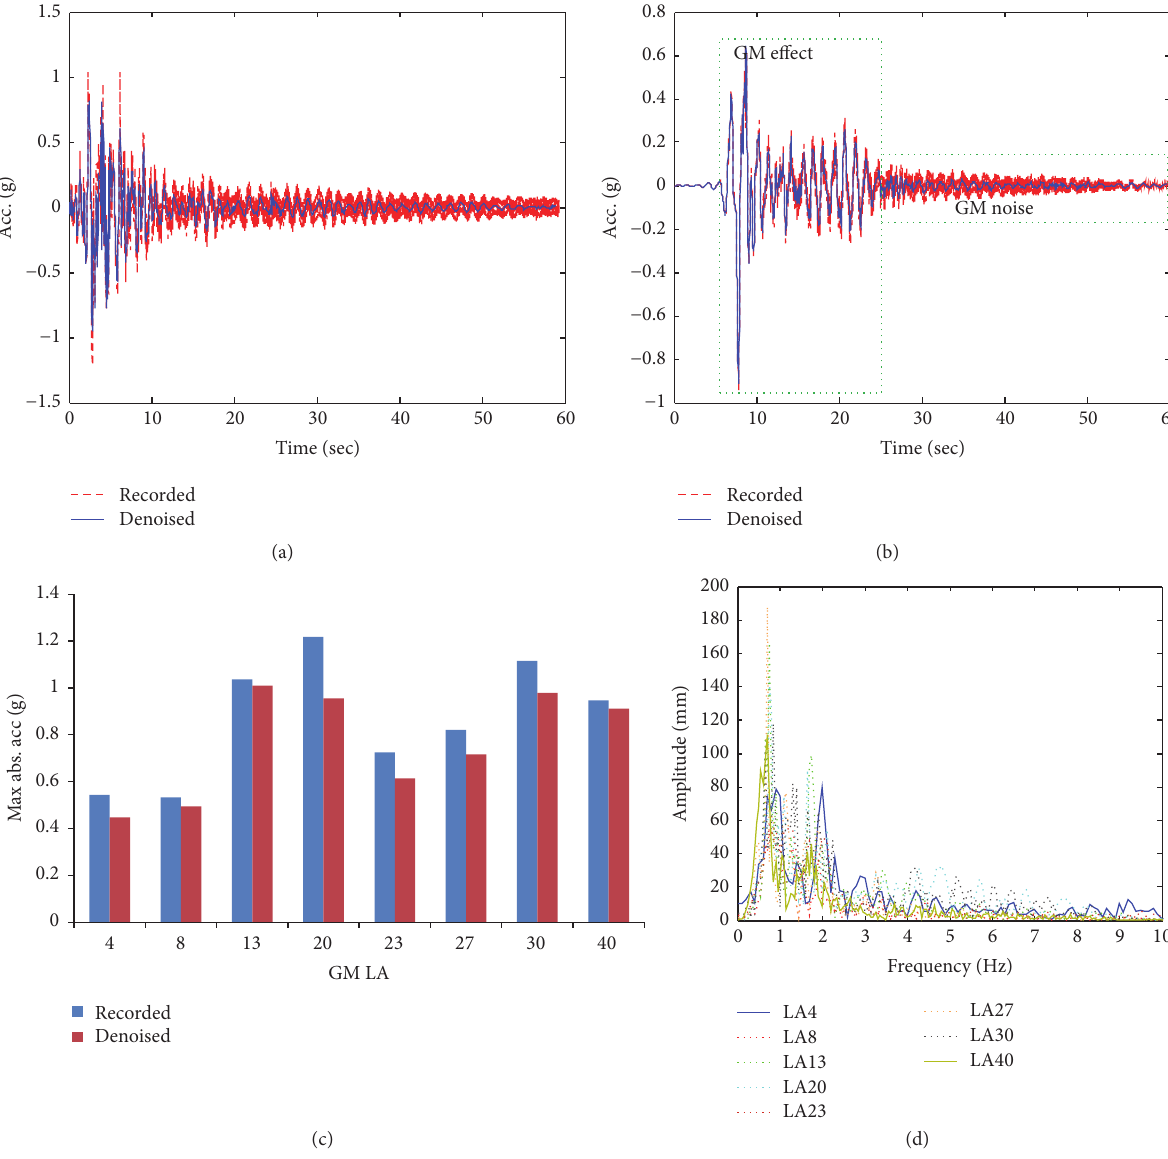
Figure 5: Structure response in time domain for the LA (a) 20, (b) 40, and (c) maximum acceleration response before and after denoising and (d) in frequency